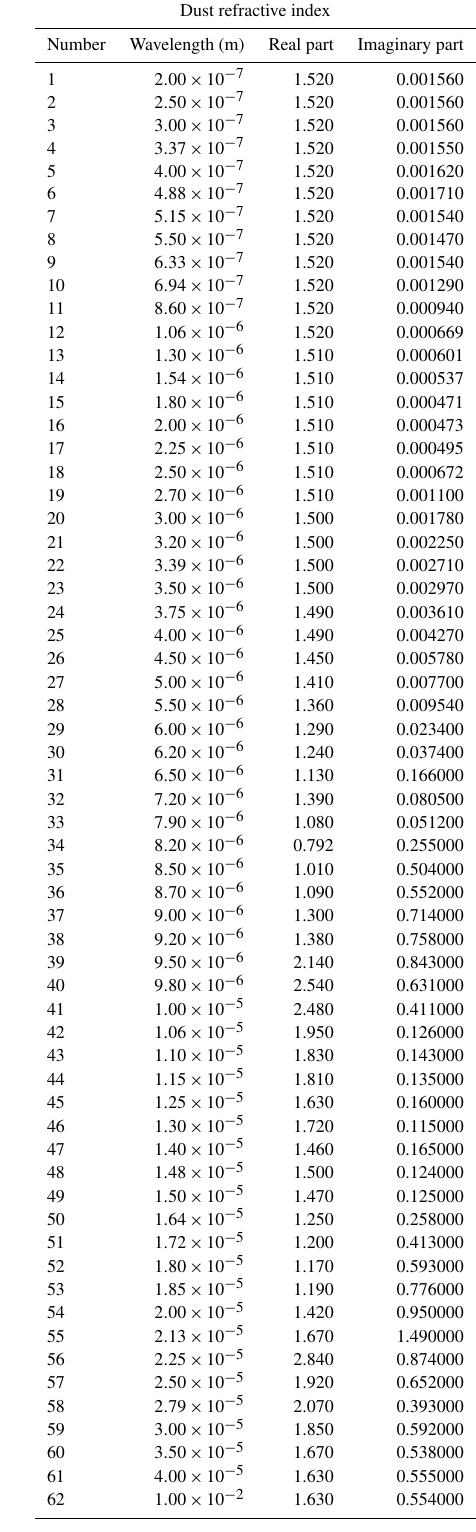
Table A1. Martian months, corresponding solar longitude ( L s ) and number of sols within that month. 0 ◦ L s corresponds to Northern Hemisphere spring equinox.